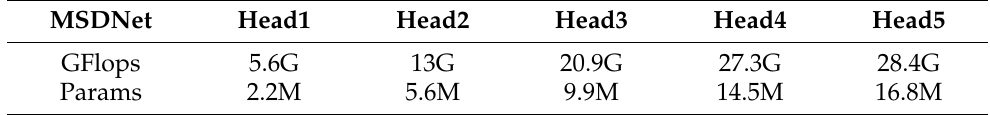
Table 1. Analysis of MSDNet’s computation and parameter amount.